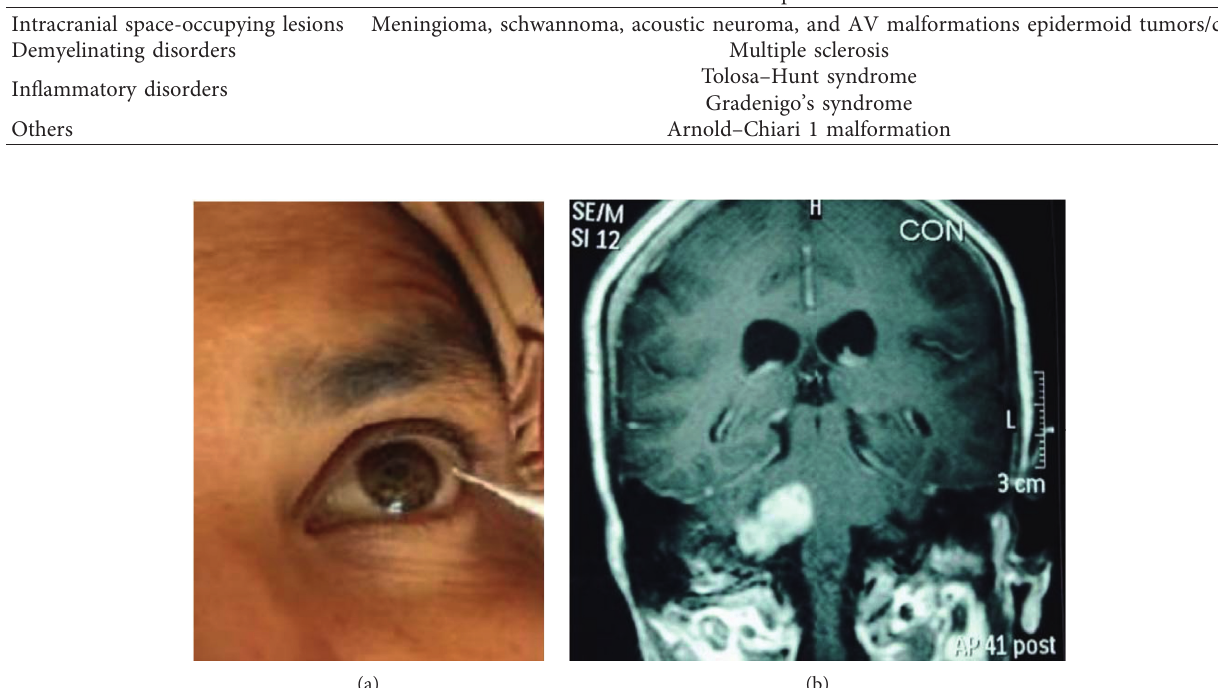
Figure 2: A 50-year-old female presenting with electric shock-like pain on the right side of the face for last 10 years. Patient had a history of multiple neurectomy of the infraorbital, mental, and inferior alveolar nerve with temporary relief followed by recurrence of symptoms. Corneal reflex was found absent. MRI revealed 2.2 × 2.2 × 2.7 extra-axial mass in the right cerebellopontine angle cistern suggestive of acoustic